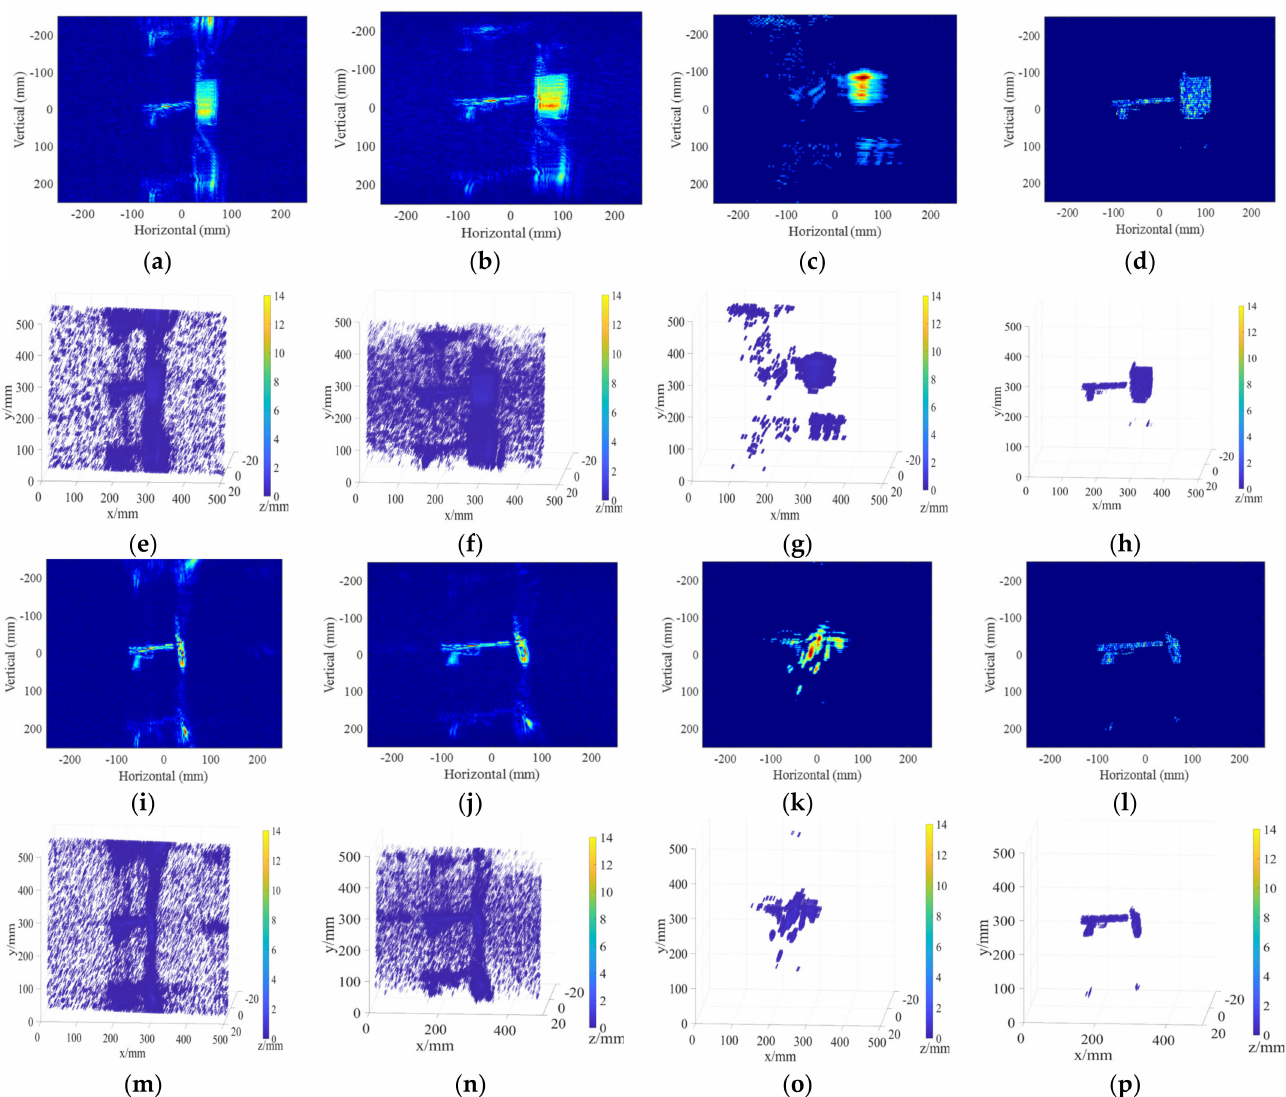
Figure 11. Imaging results of multiple targets using different algorithms. Rows 1 ( a – d ) and 3 ( i – l ) are the 2D imaging results; Rows 2 ( e – h ) and 4 ( m – p ) are the 3D imaging results; Rows 1 and 2 are the results for the pistol and knife; Rows 3 and 4 are the results for the pistol and stiletto; Column 1 is the BPA imaging results; Column 2 is the RMA imaging results; Column 3 is the OMP imaging results; Column 4 is the proposed method imaging